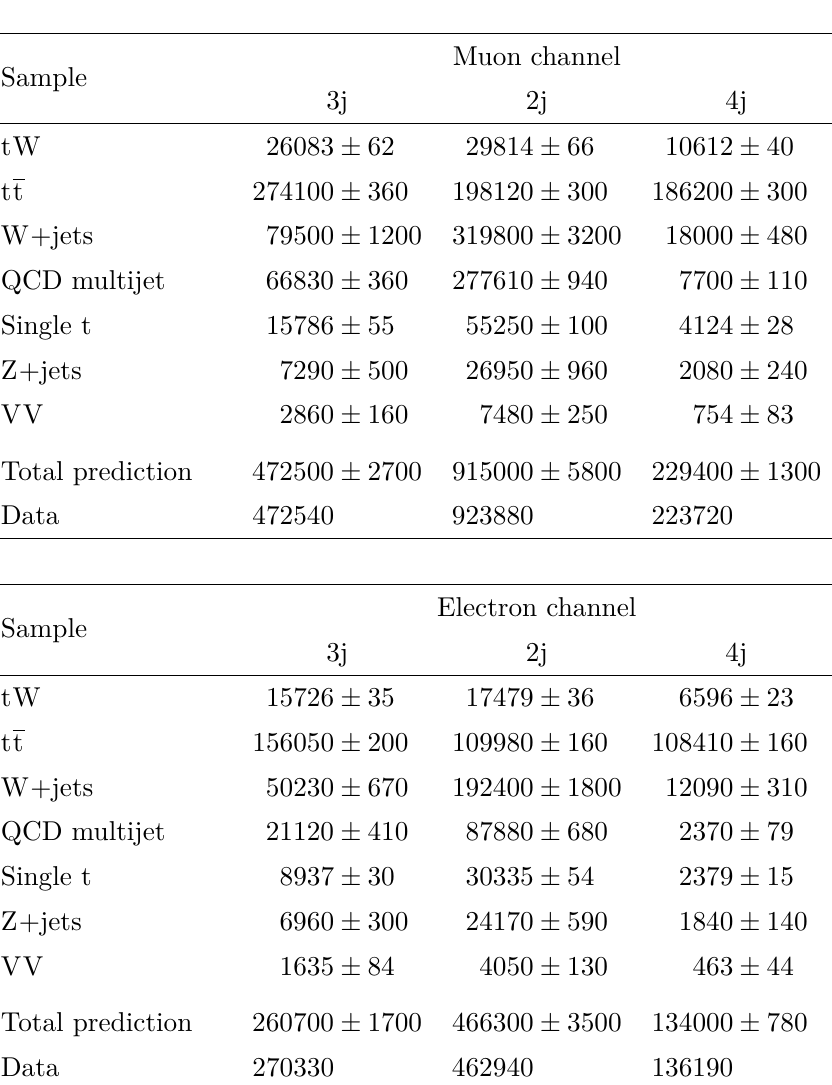
Table 1 . The total number of events passing the event selection in each analysis region and their associated statistical uncertainties. The event yields are given for the tW signal and all major backgrounds for both the muon (upper) and electron (lower) channels. These values are provided for reference using simulation and scaled to the SM cross sections, with the exception of the QCD multijet background, which is taken from a data-based method, and the W +jets background, which uses the SM cross section corrected using a data-based method. A more precise estimation is obtained from the final fit, as described in the text. The single t background is comprised of the t - and s -channel single top quark